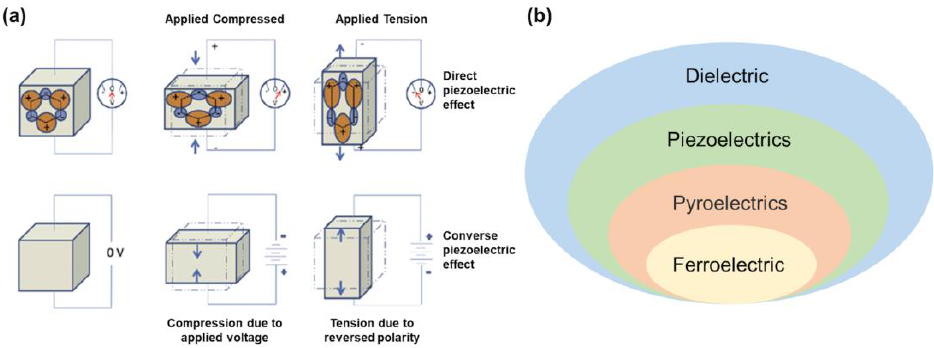
Figure 1. ( a ) Schematic of direct and converse piezoelectric effect [30]; ( b ) the affiliations of dielectric, piezoelectric, pyroelectric, and ferroelectric.